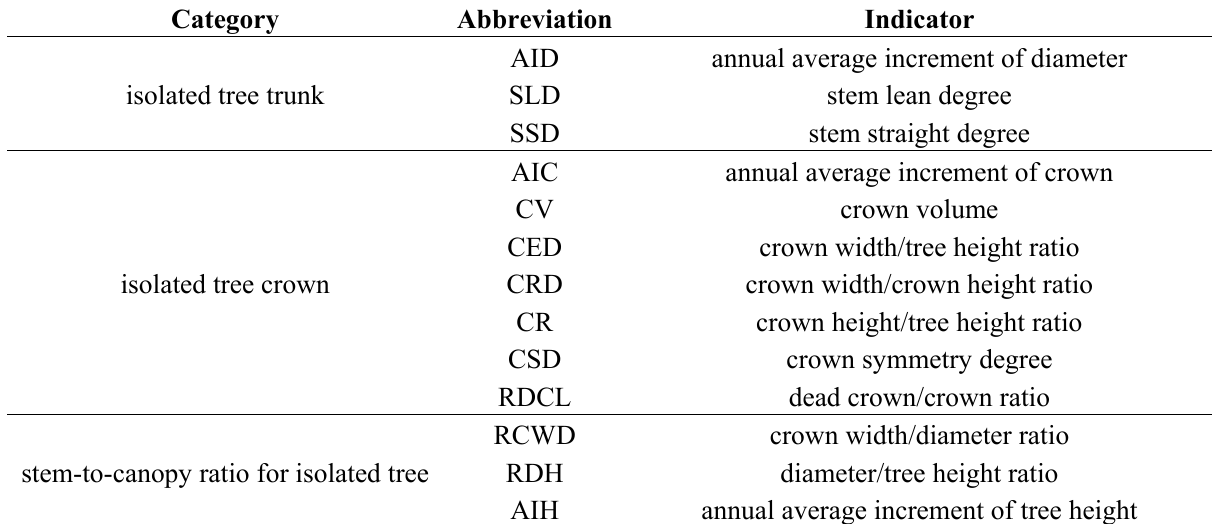
Table 2. The abbreviations and descriptions of individual tree